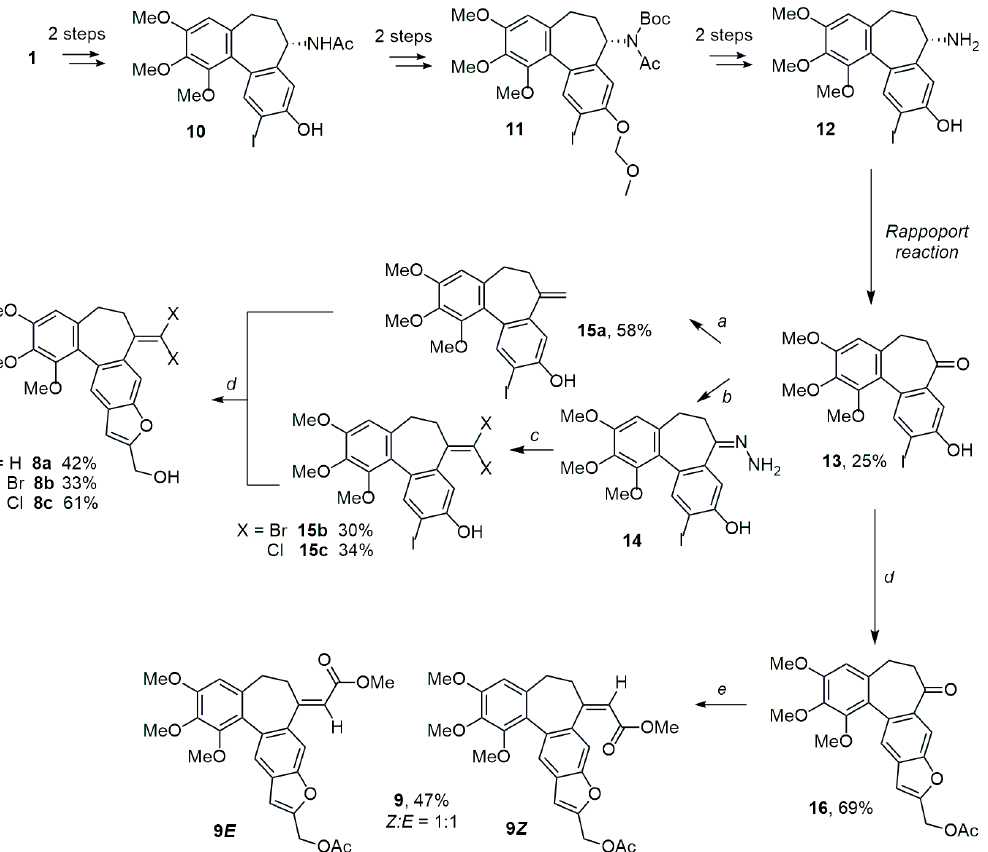
Scheme 1. Synthesis of colchicinoids 8 and 9 . Reagents and conditions: ( а ) Ph 3 PMeI, t -BuOK, THF,